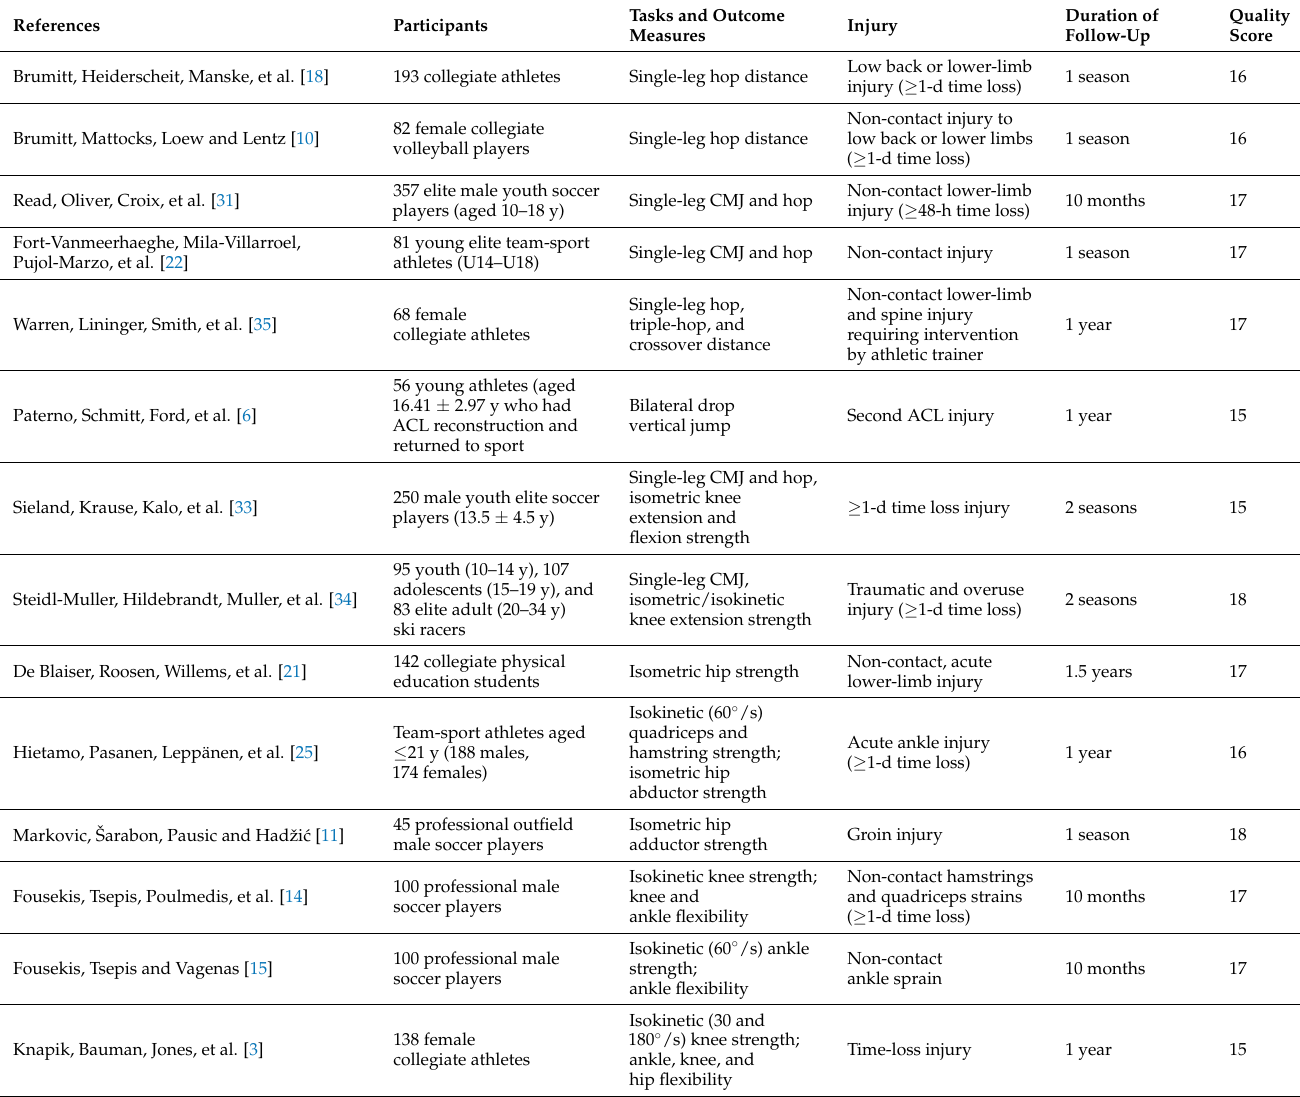
CMJ, single-leg countermovement jump; ACL, anterior cruciate ligament. Three studies examined the association between inter-limb asymmetries in lower-limb muscle flexibilities and sport injury (Table 2). Outcome measurements included the range of motion ( ◦ ) in the ankle, knee, and hip measured with a goniometer. Characteristics of the 15 studies focusing on dynamic balance (measured with the SEBT and Y balance test) are listed in Table 3. Reach distances at the anterior, posteromedial, and posterolateral direction were measured for each leg. Inter-limb asymmetry in reach distance at each direction was